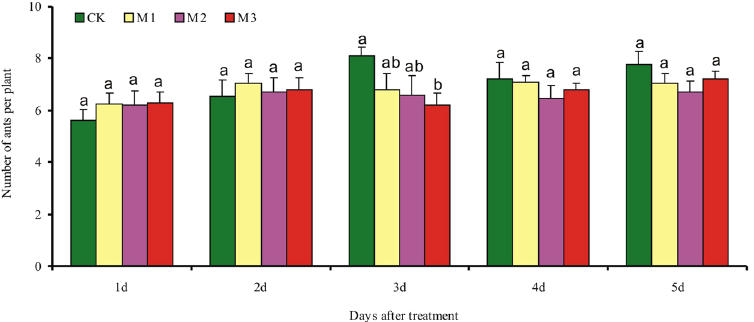
Figure 2. Ant responses to mealybug damage (experiment 2). Plants with one of four levels of mealybugs (CK = 0, M1 = 30, M2 = 60, and M3 = 90 per plant) were placed on a rack sitting in a box with ca. 200 workers plus two queens; the ants in the box could move up the rack to the plants but could not contact the mealybugs because the petioles were coated with petrolatum. The number of ants per plant was then recorded on 5 consecutive days.